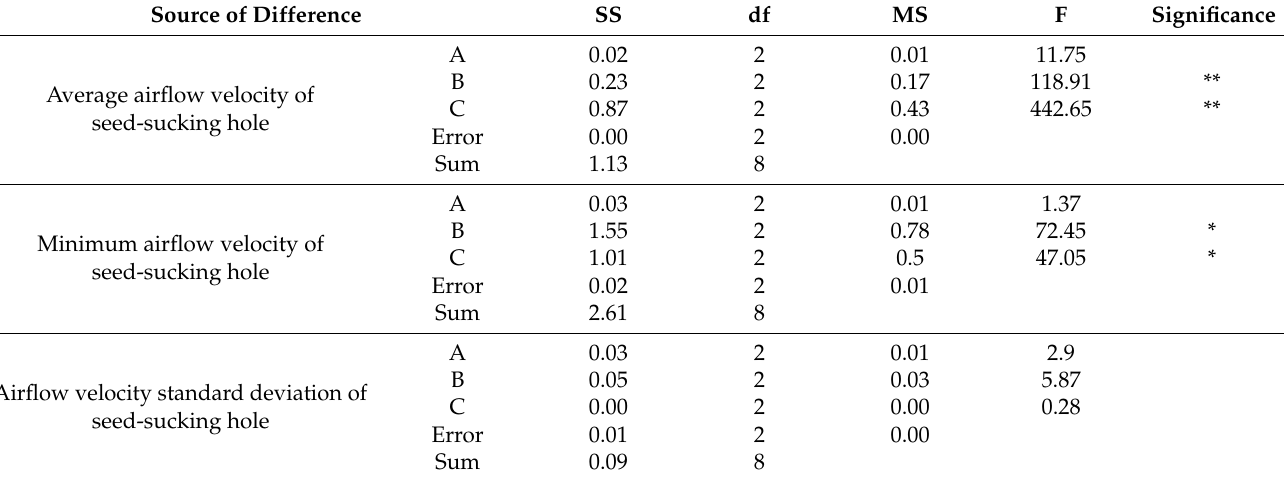
Table 4. Variance